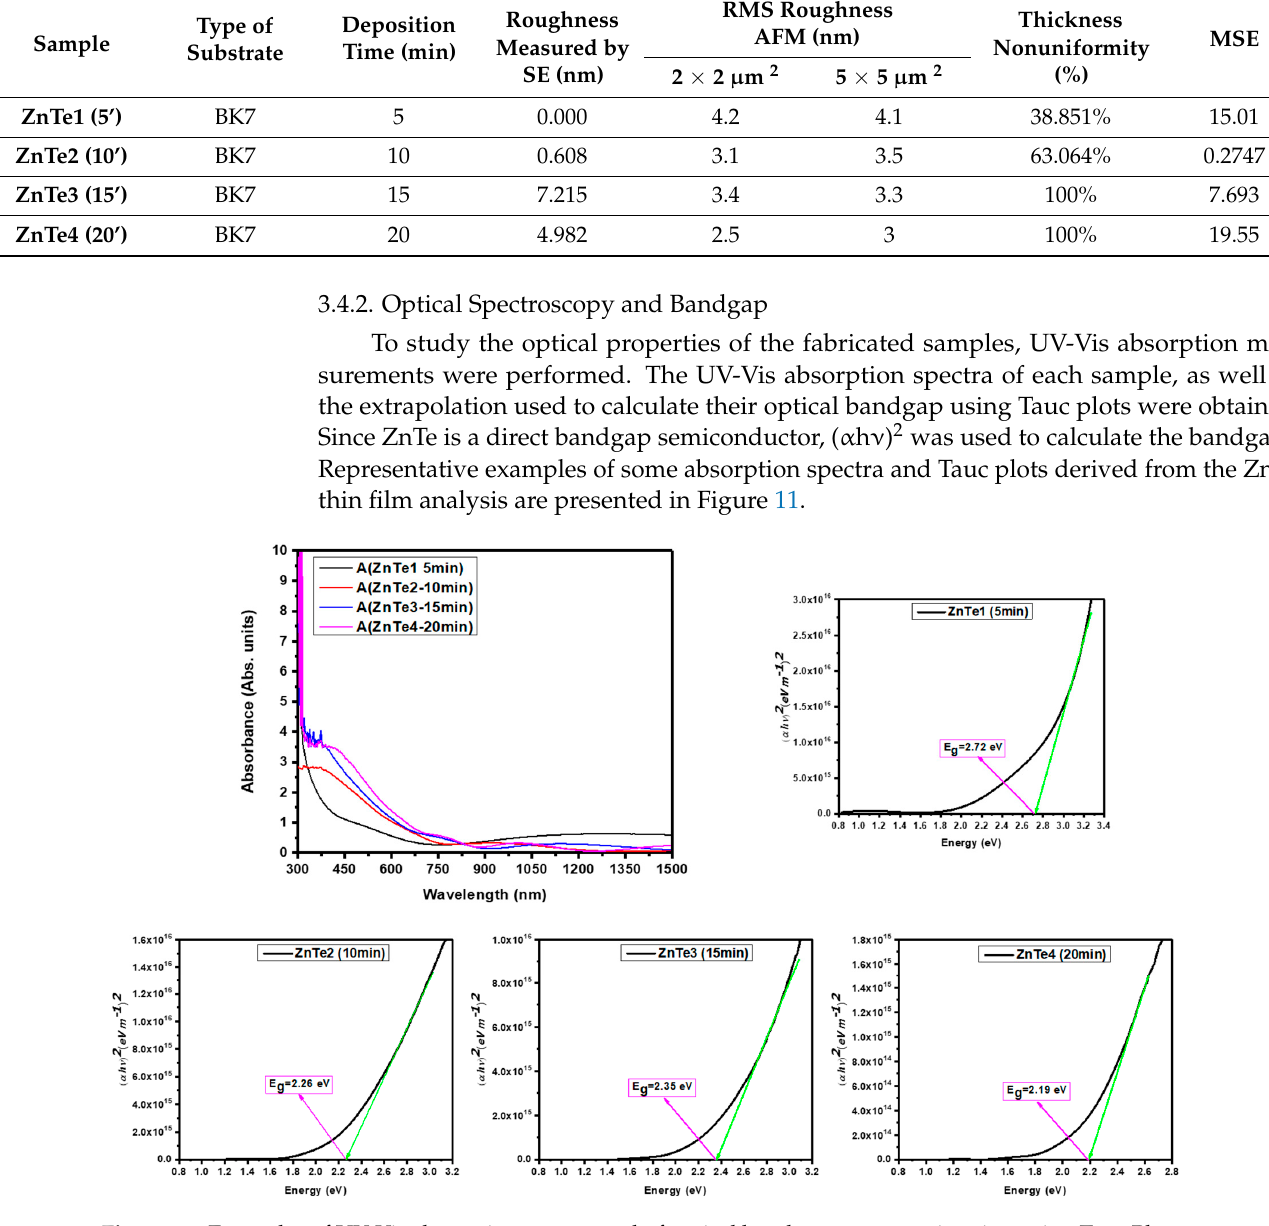
Figure 11. Examples of UV-Vis absorption spectra and of optical bandgap energy estimation using Tauc Plots. Bandgap energy (Eg) values obtained for the optimized materials are presented in Table 4. Table 4. Bandgap values. Sample